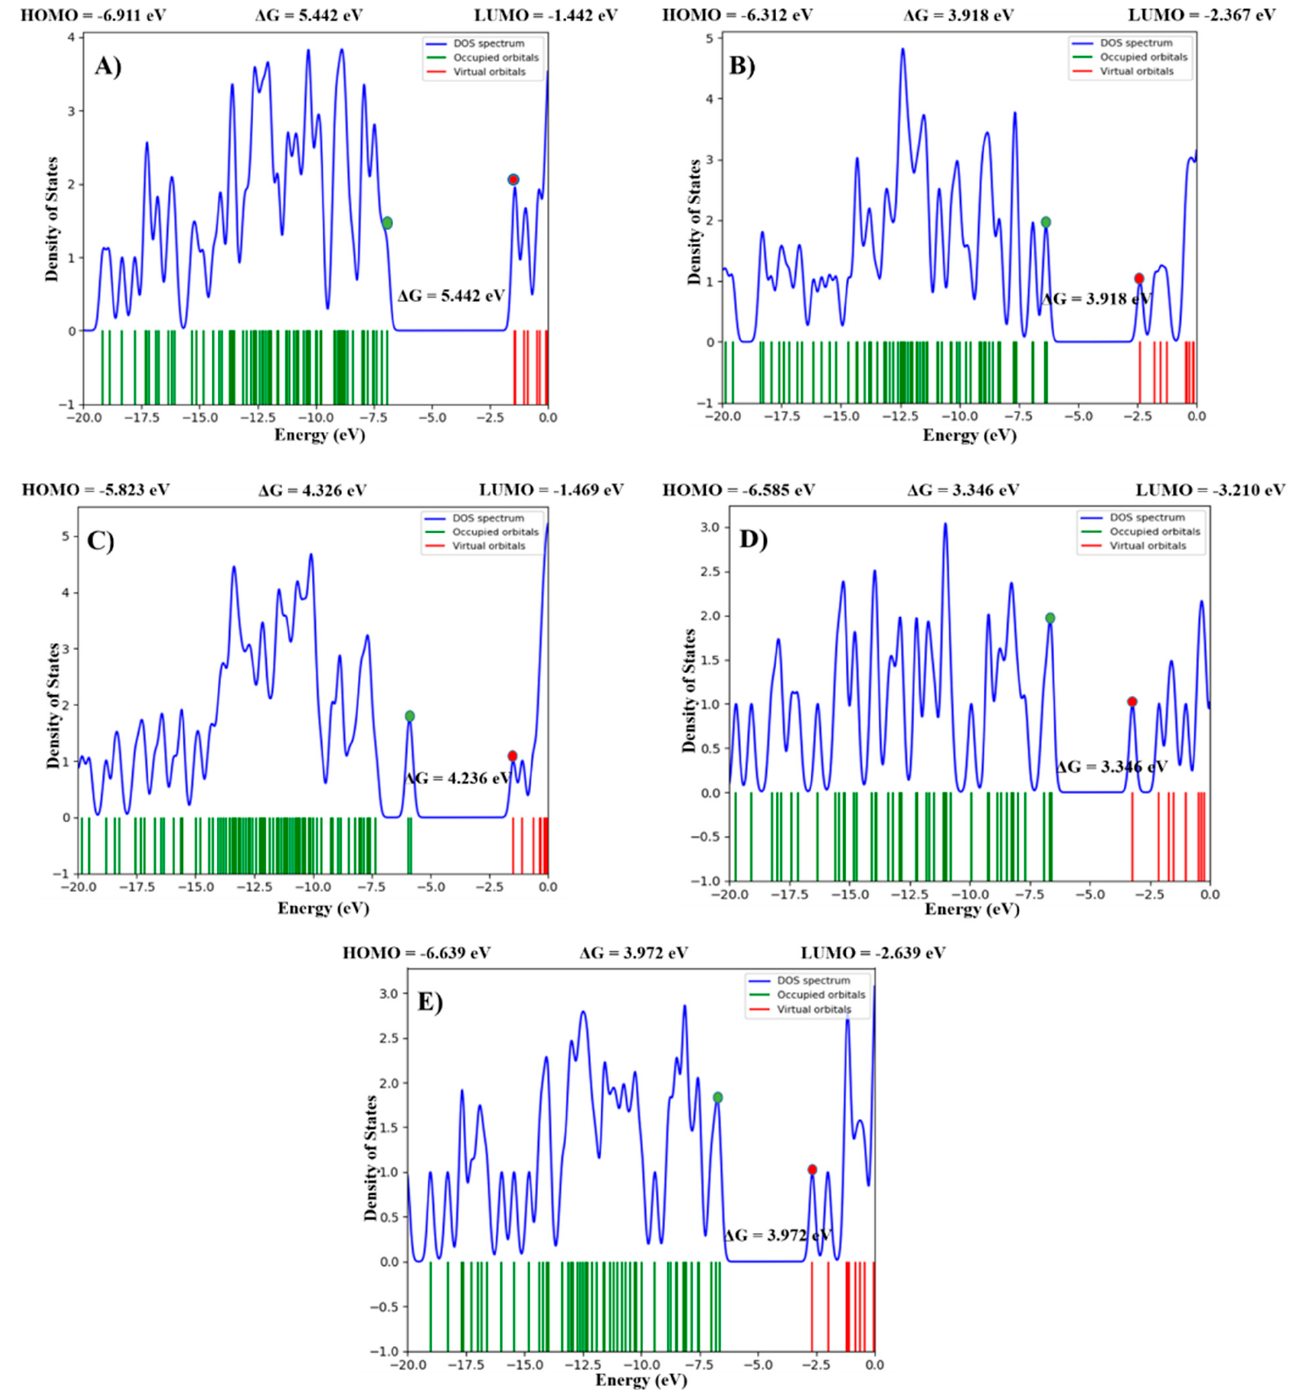
Figure 3. Density of states (DOS) plot of HOMO LUMO and energy gap of the five selected com- pounds ( A ) AKS-01, ( B ) AKS-02, ( C ) AKS-03, ( D ) AKS-04, and ( E ) AKS-05. Green and Red dots shows HOMO and LUMO orbitals.